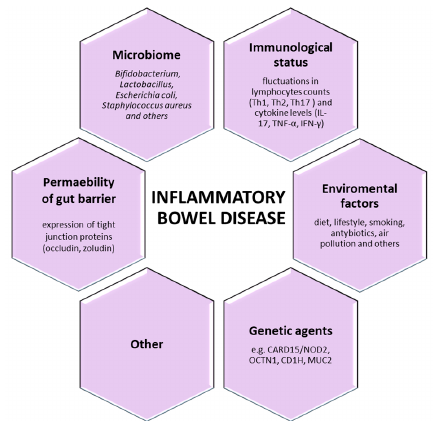
Figure 1. The key players in inflammatory bowel disease.